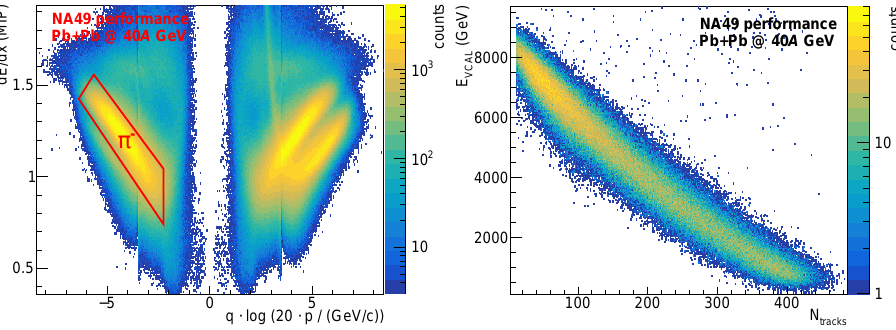
Figure 2. Left: track dE / dx as a function of momentum for di ff erent charges. Region used for negatively charged pion selection is indicated by the red box. Right: Anticorrelation between VCAL energy and number of primary tracks in the TPCs pions were selected using dE / dx measurements from all TPCs (Fig. 2,